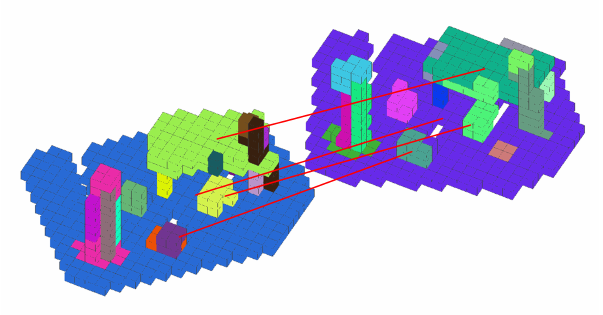
Figure 12: True matches from cluster-based EGI